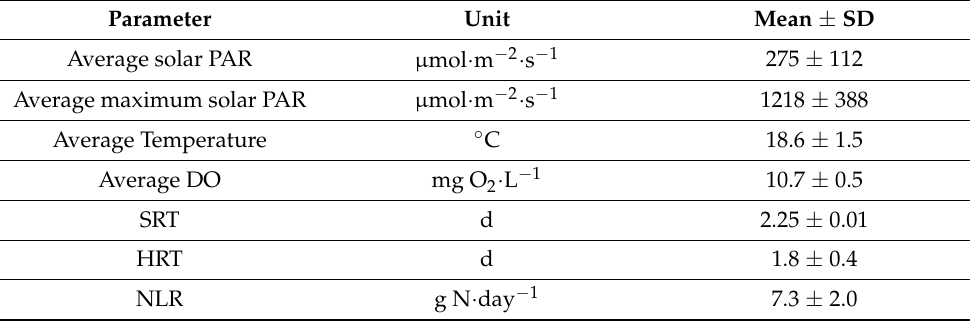
Table 2. Operation and outdoor conditions of the MPBR operating